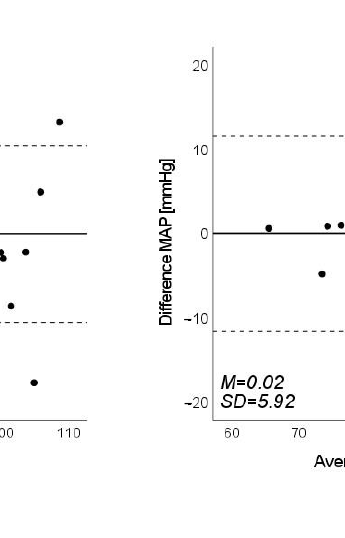
Figure 11. Bland–Altman plots of estimated mean arterial pressure (MAP) against those measured with a cuff sphygmomanometer ( N = 42). From left to right, the light source is blue (B), green (G), red (R), and near-infrared (NIR). The solid line and the dashed lines on each plot represent fixed bias (M) and M ± 1.96 standard deviation range, respectively. Table 4. Difference between estimated BP and measured BP with a cuff sphygmomanometer. SBP 1 BP = blood pressure; SBP = systolic BP; DBP = diastolic BP; MAP = mean arterial pressure; B = blue LED; G = green LED; R = red LED; NIR = near-infrared LED; mean = average difference between measured BP and estimated BP; SD = standard deviation of difference between measured BP and estimated BP; and 0‒5, 5‒10, 10–15, and >15 mmHg: number of data when the error is divided into 4 classes.